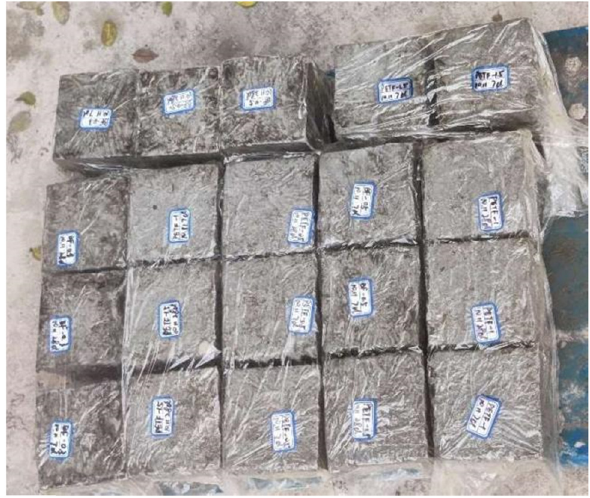
Figure 3: Concrete specimens placed in oven for